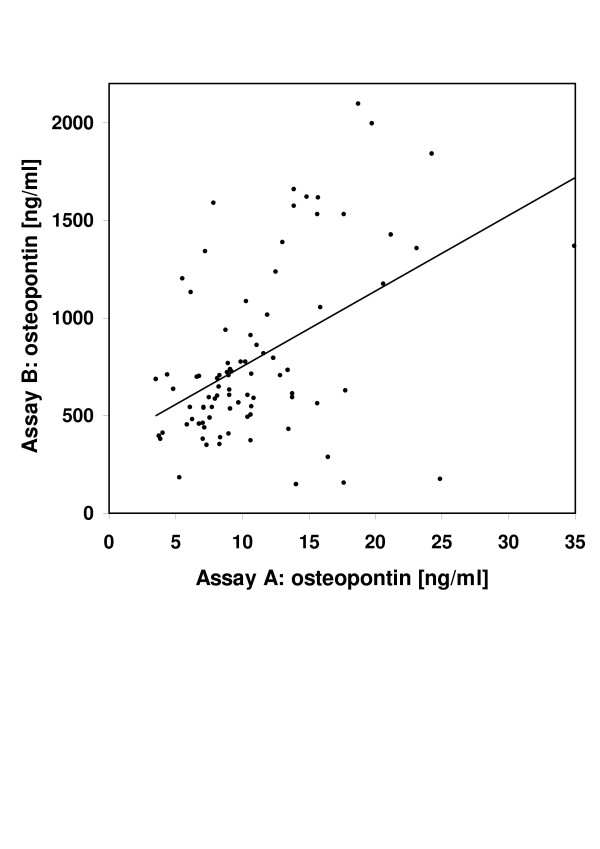
Osteopontin levels in individual plasma samples obtained from cervix or head and neck cancer patients undergoing radiotherapy. All samples were measured with two different ELISA systems, a newly introduced assay (A) and an older assay (B) marketed under two different names (see text). The results of both assays were significantly correlated (p < 0.05, Spearman rank test). For clarity, two data points with values of 80.5 and 189.5 ng/ml for assay A are not displayed.